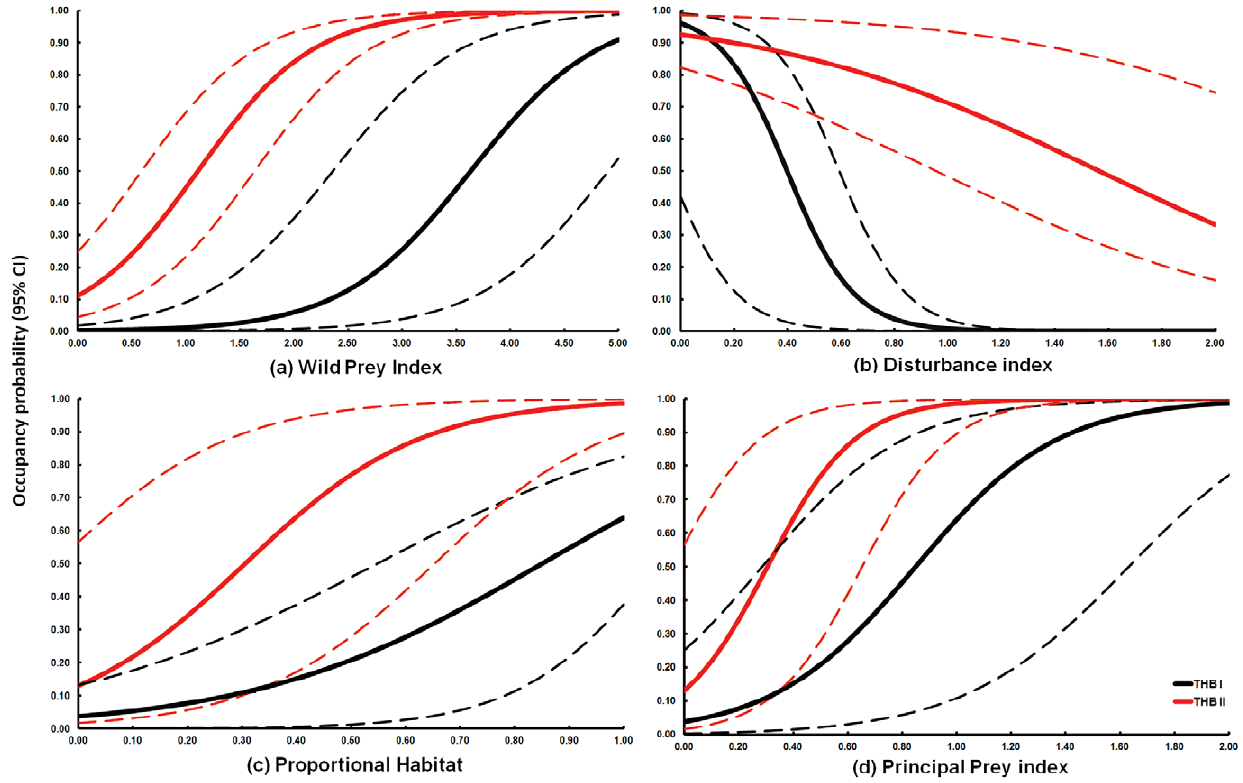
Figure 3. Relationship between occupancy probability (y-axis) and explanatory variables across THB I and THB II. (a) wild prey index, (b) disturbance index, (c) proportional habitat and (d) principal prey index. Dashed lines represent 95% confidence intervals.